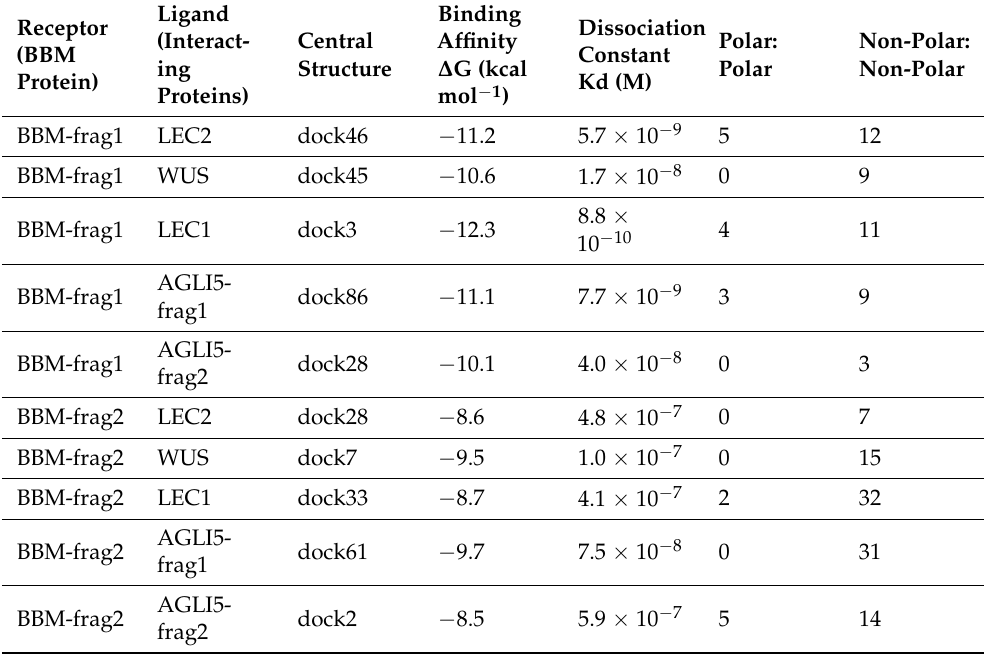
Table 3. The binding affinity and the dissociation constant values with their respective central structure number and interfacial contact between BBM and interacting proteins.